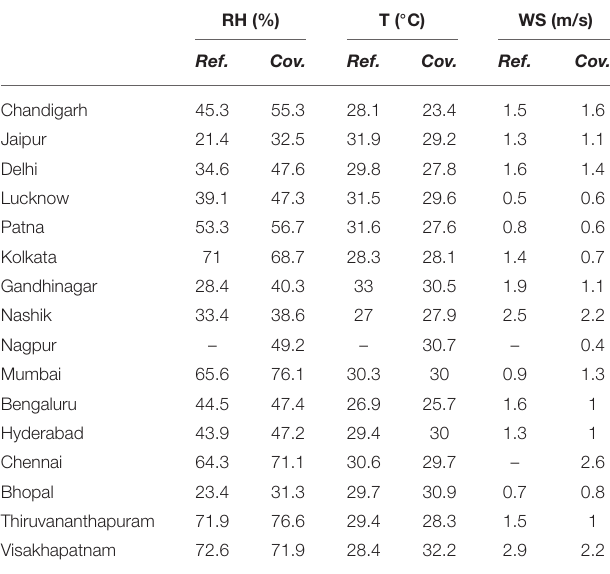
TABLE 2 | Mean values of meteorological parameters during complete lockdown period (in 2020, as Cov.) and reference period (as